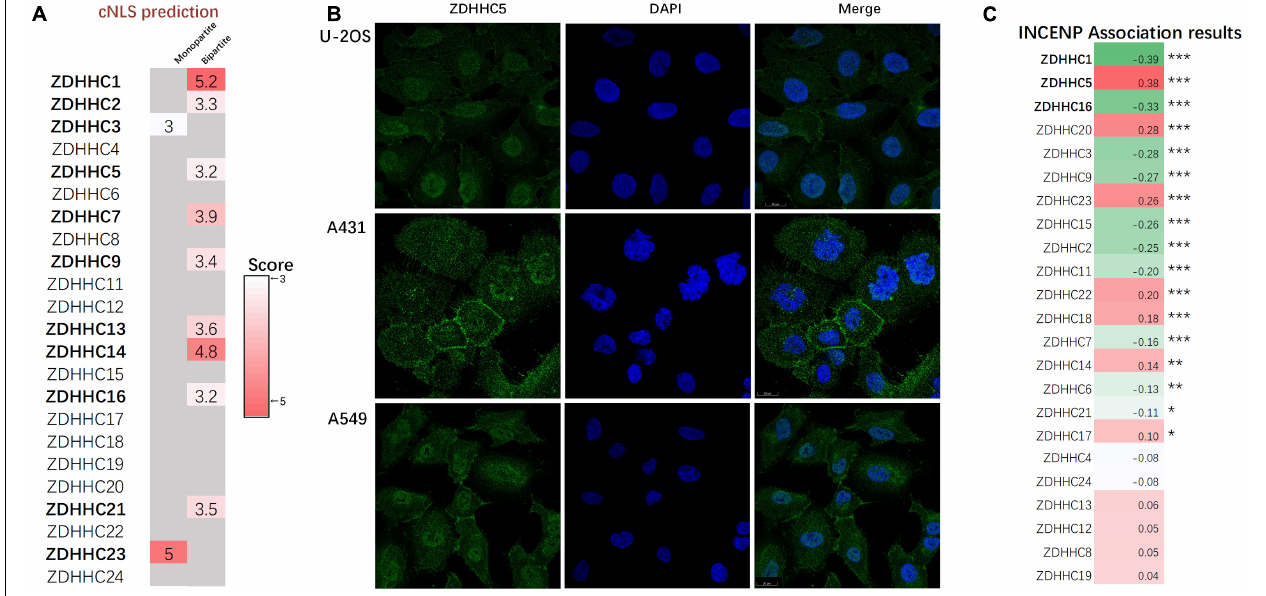
FIGURE 5 | ZDHHC5 is the only nuclear ZDHHC family member correlated with INCENP. (A) Results of ZDHHCs nuclear localization signals (NLSs) are shown in the heatmap, calculated by cNLS Mapper. The cNLS Mapper scans the protein sequence with a window size of 16 amino acid residues for monopartite NLSs and 26–28 amino acid residues for bipartite NLSs. (B) Immunofluorescence images (HPA) show the subcellular localization of the nuclear ZDHHC proteins (green) with reference DAPI (blue) for the nucleus in cell lines. (C) Pearson correlation analysis of INCENP and ZDHHCs in the LUAD. The color represents the corresponding correlation value. Red, positive association; green, negative association. | Pearson coefficient | > 0.3 and P < 0.05 is significant. * P < 0.05, ** P < 0.01, *** P <